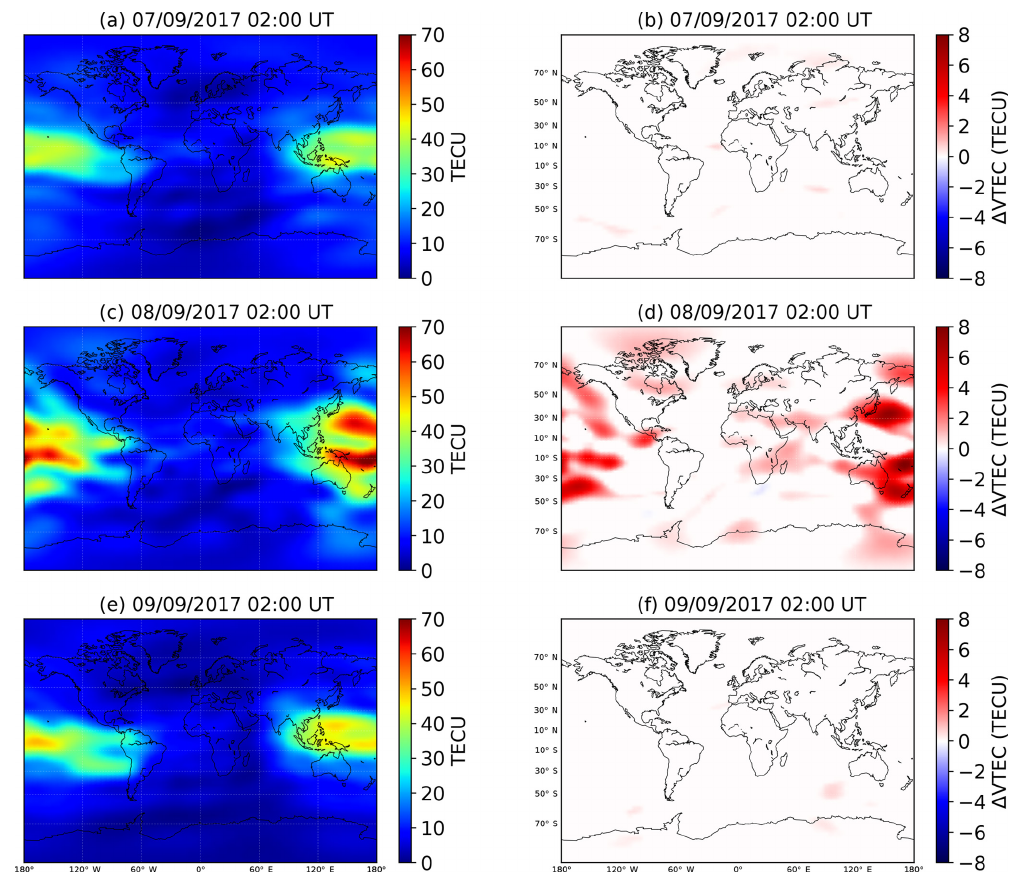
Figure 2. (a) Global ionospheric maps for 7, 8 and 9 September 2017 at 02:00UT. (b) Differential VTEC maps for 7, 8 and 9 September 2017 at